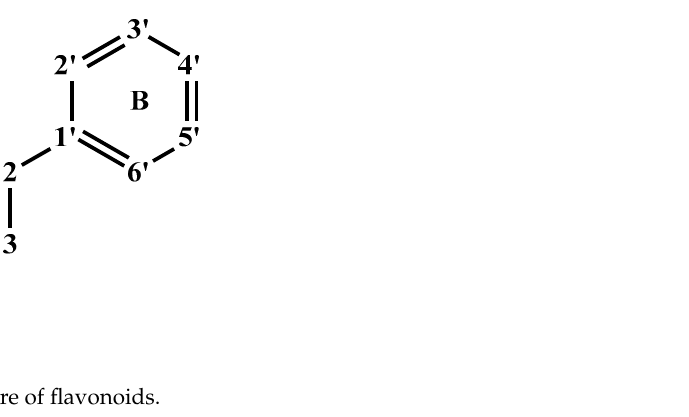
Table 3 . Minimum inhibitory concentration (MIC) and minimum bactericidal concentration (MBC) of the Hypericum species against E. coli , S. enteritidis , S. aureus , and E. faecalis bacteria.